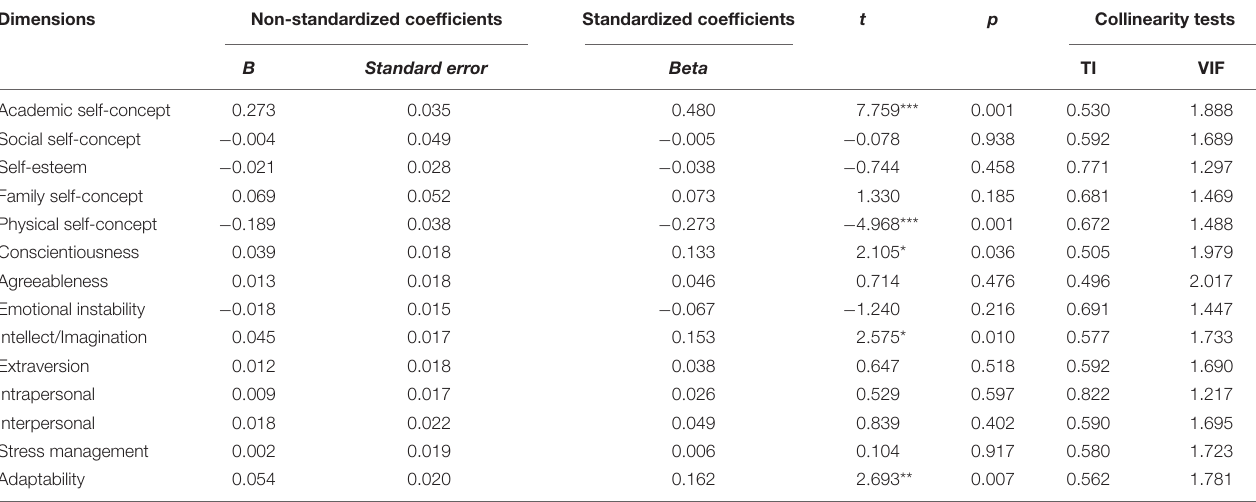
TABLE 6 | Regression analysis of the different dimensions analyzed with respect to the mathematics subject.